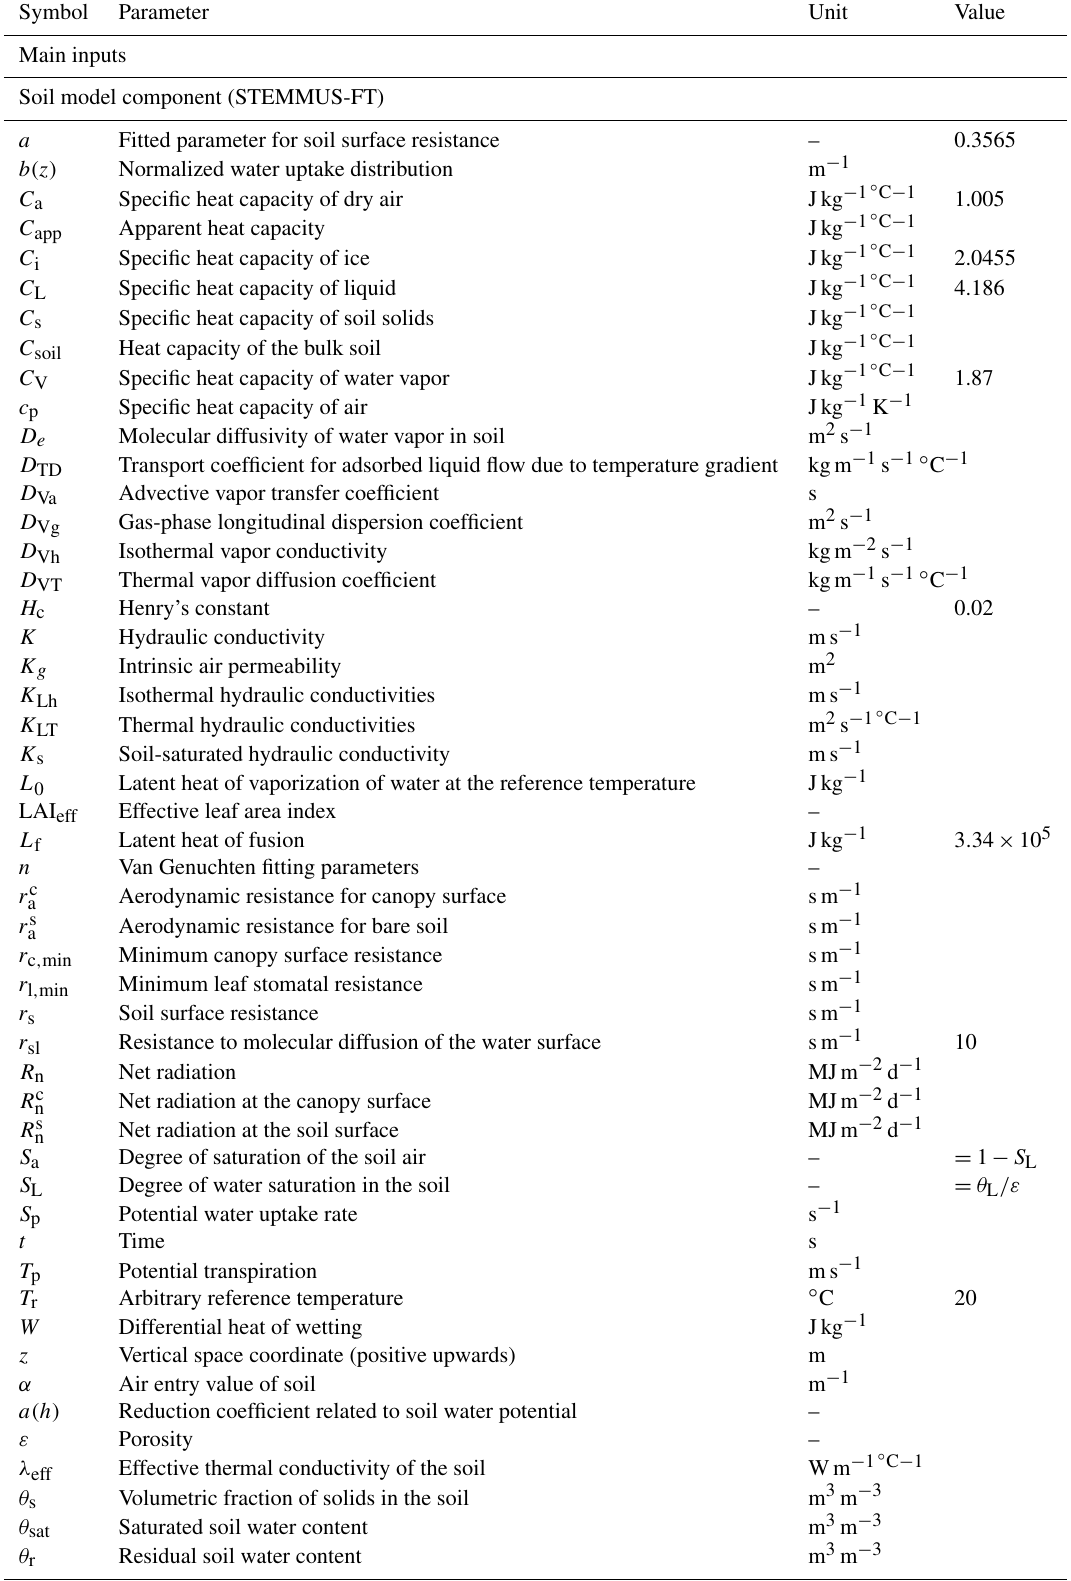
Table B1. Notation. Symbol Parameter Unit Value Main inputs Soil model component